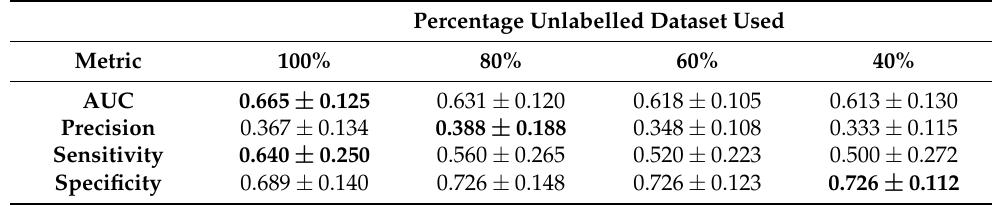
Table 9. Performance results for different percentages of the unlabelled dataset used when considering a weighted loss function and a manifold regularisation term.